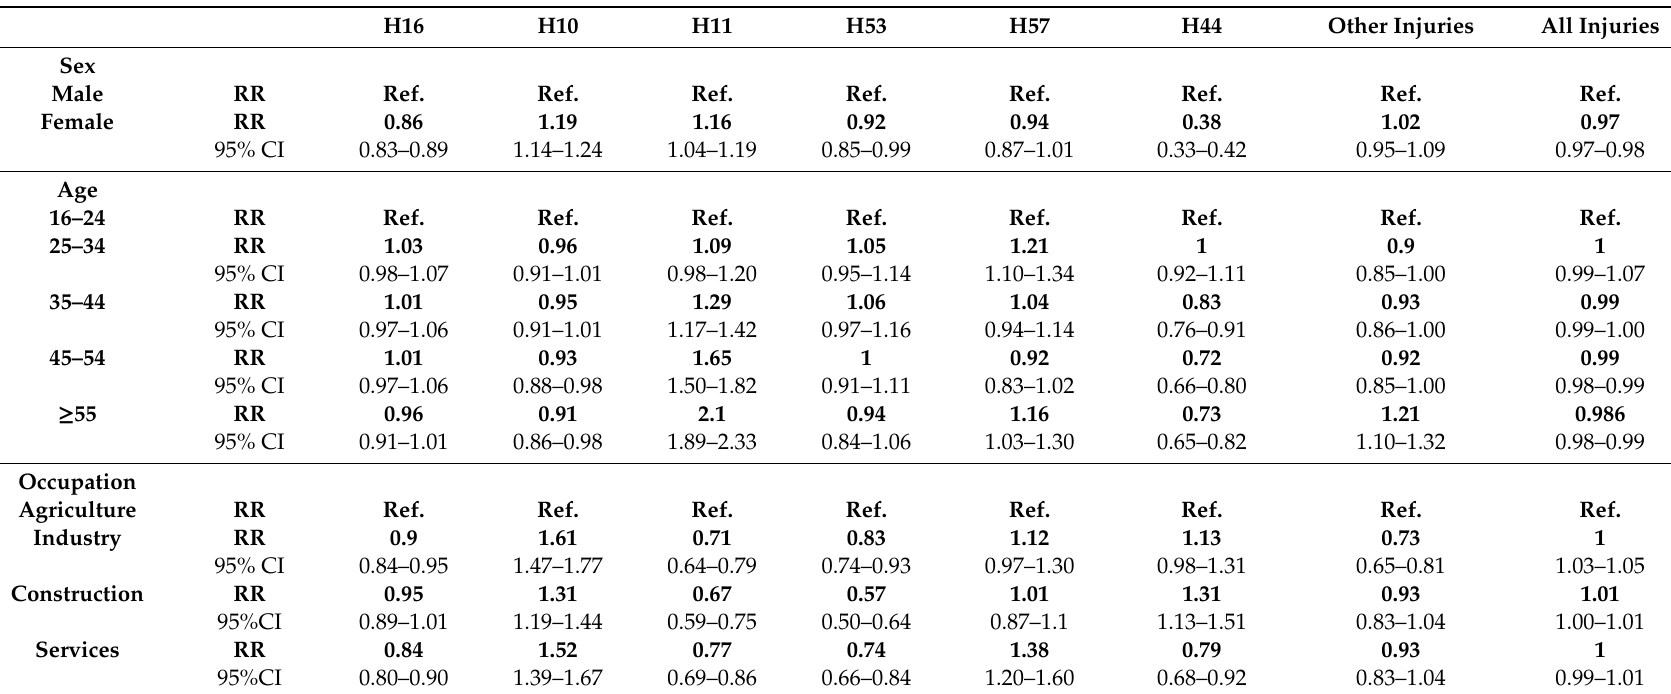
Table 4. Results from the negative binomial regression about the relative risk of su ff ering WREI according to sex, age and